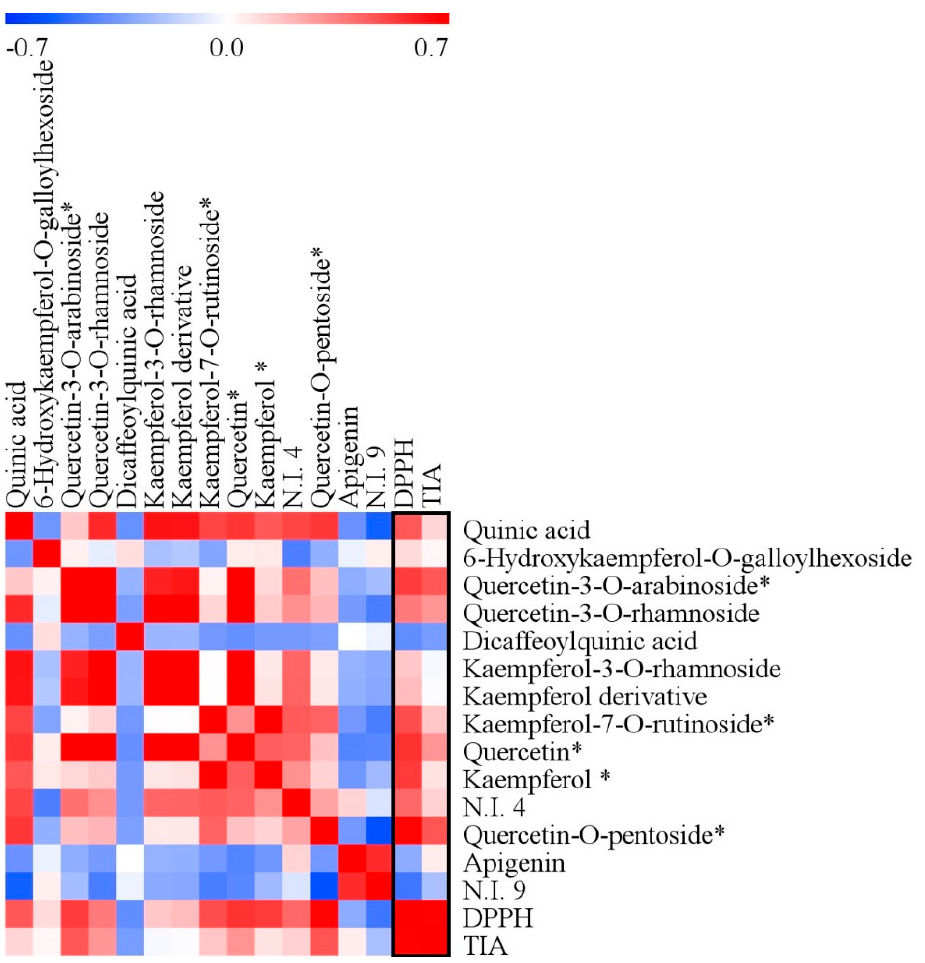
Figure 5. Correlation map of metabolites analyzed by ultrahigh performance liquid chromatography (UHPLC)-linear trap quadrupole-ion trap (LTQ-IT) mass spectrometry/mass spectrometry (MS/MS) with antioxidant and tyrosinase inhibition activities. Each square indicates r (Pearson’s correlation coefficient values for a pair of metabolites or antioxidant activity). The red color indicates positive (0 < r < 0.7) correlation and blue color indicates negative ( − 0.7 < r < 0) correlation. * The correlation coefficients of five metabolites are statistically significant at a level of 0.05 in bioactivities.